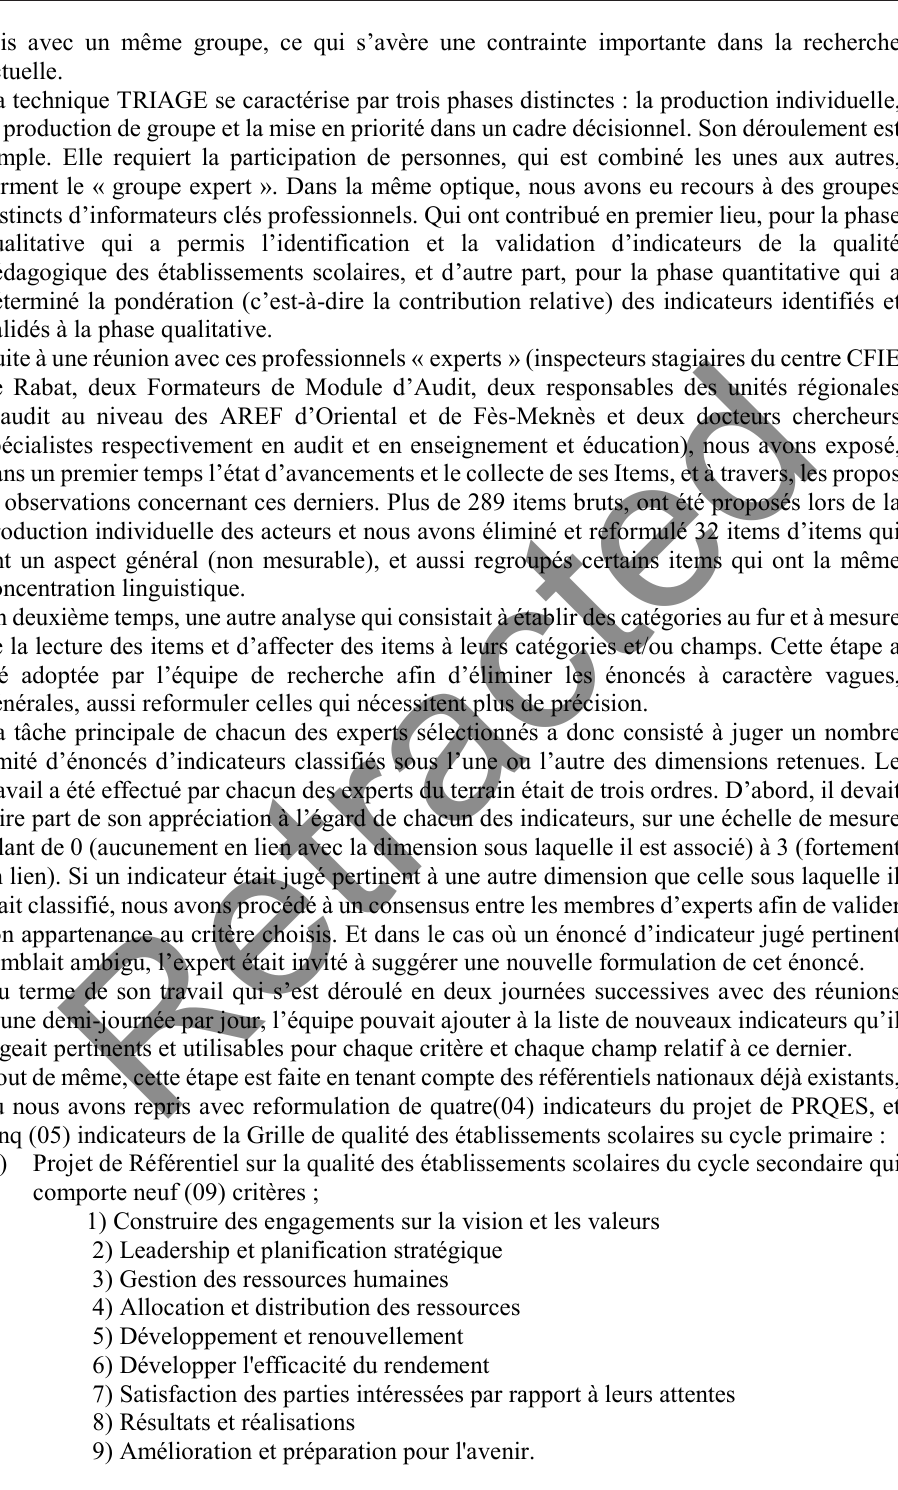
Figure 3 : Analyse et Catégorisation des